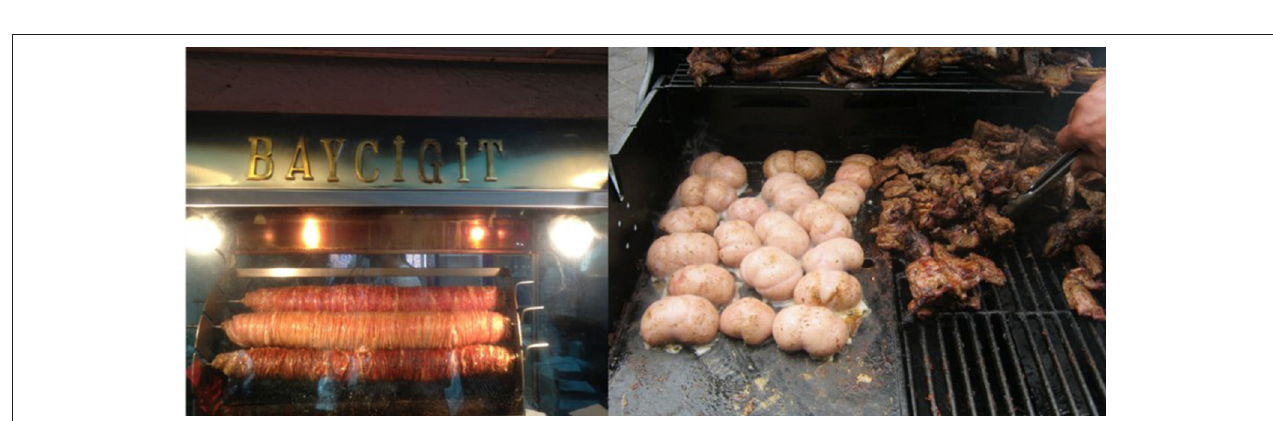
FIGURE 6 | Forms of organ meat cooking and utilization. (Left) Shows sheep intestines being roasted for slicing and incorporating into fast-food meals in Izmir Turkey. (Right) Shows lamb meat and testicles barbecued side by side, demonstrating a possible combination of muscle and organ meats in a meal.